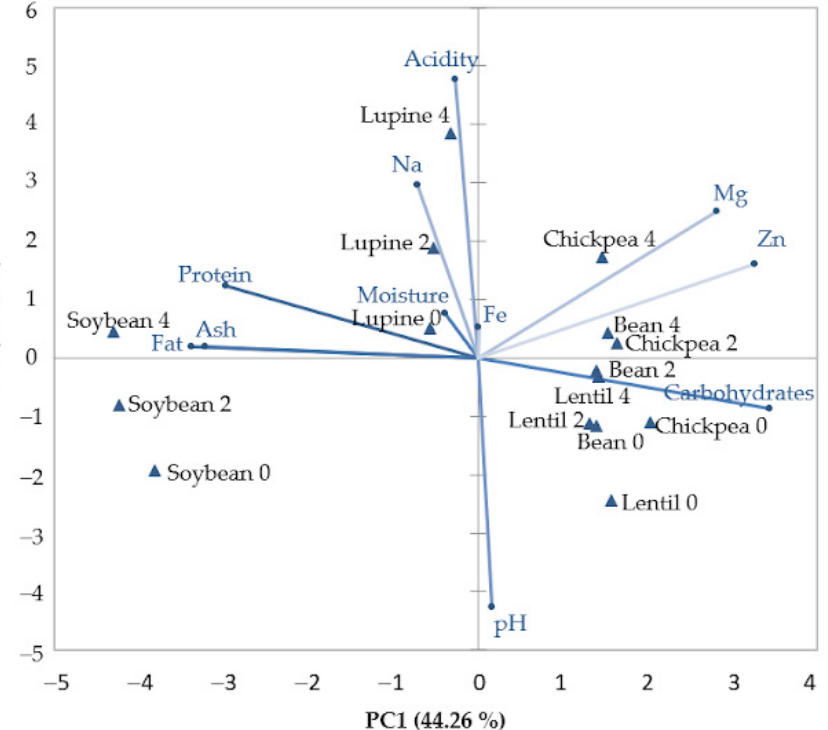
Figure 4. Principal component analysis for physico-chemical values of legume seeds during the germination